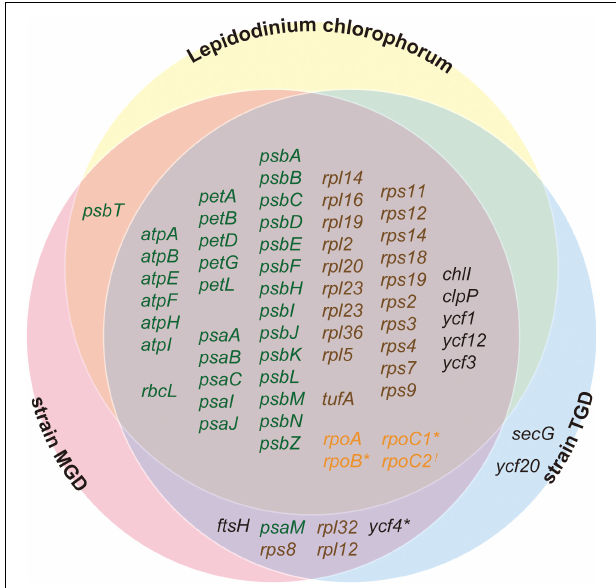
FIGURE 6 | Venn diagram for the functionally assignable ORFs in the three peDinoflagellate plastid genomes. Open reading frames (ORFs) encoding proteins involved in photosynthesis, translation, transcription, and other function are colored in green, brown, orange, and black, respectively. Notes, rpoC1 in Lepidodinium chlorophorum , rpoB in strain TGD, and ycf4 in strain MGD are pseudogenes and marked by asterisks. rpoC2 is highlighted by an exclamation mark as the N- and C-termini of RpoC2 are encoded in two distinct ORFs in strain TGD (see Figure 1 ).